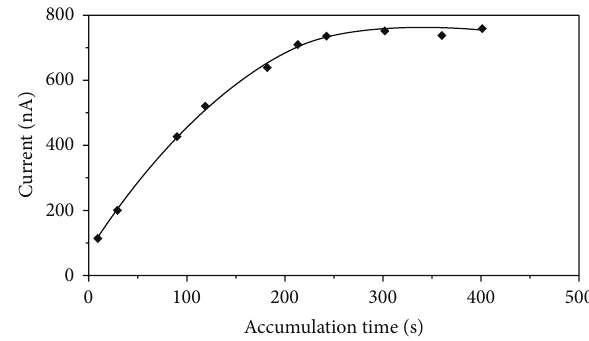
Figure 3: Dependence of peak current on square root of scan rate by staircase cyclic voltammetry for 1.7 × 10 −6 mol L −1 of Ni(II)-salen complex in phosphate buffer (circle) and Hepes (triangle) buffers (0.02 molL −1 , pH 7.0). Equilibrium time of 30s at − 800 mV.